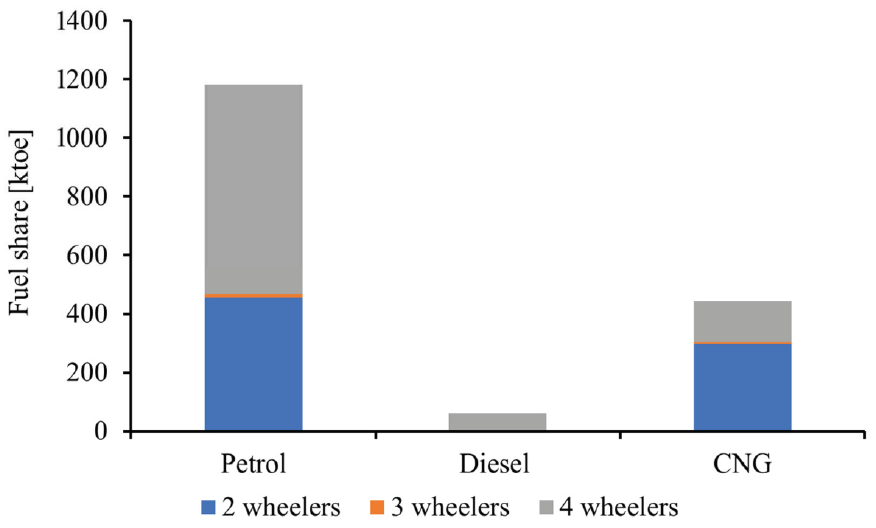
Figure 10. Fuel share of the transportation sector (year 2020).